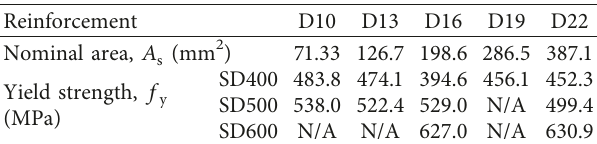
Table 3: Nominal area and yield strength of steel reinforcement.